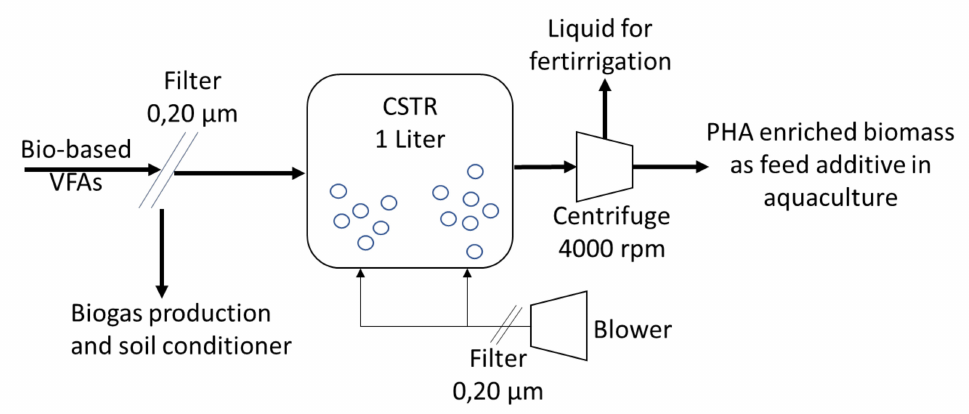
Figure 1. Experimental set-up used for the production of PHA-rich microbial biomass.